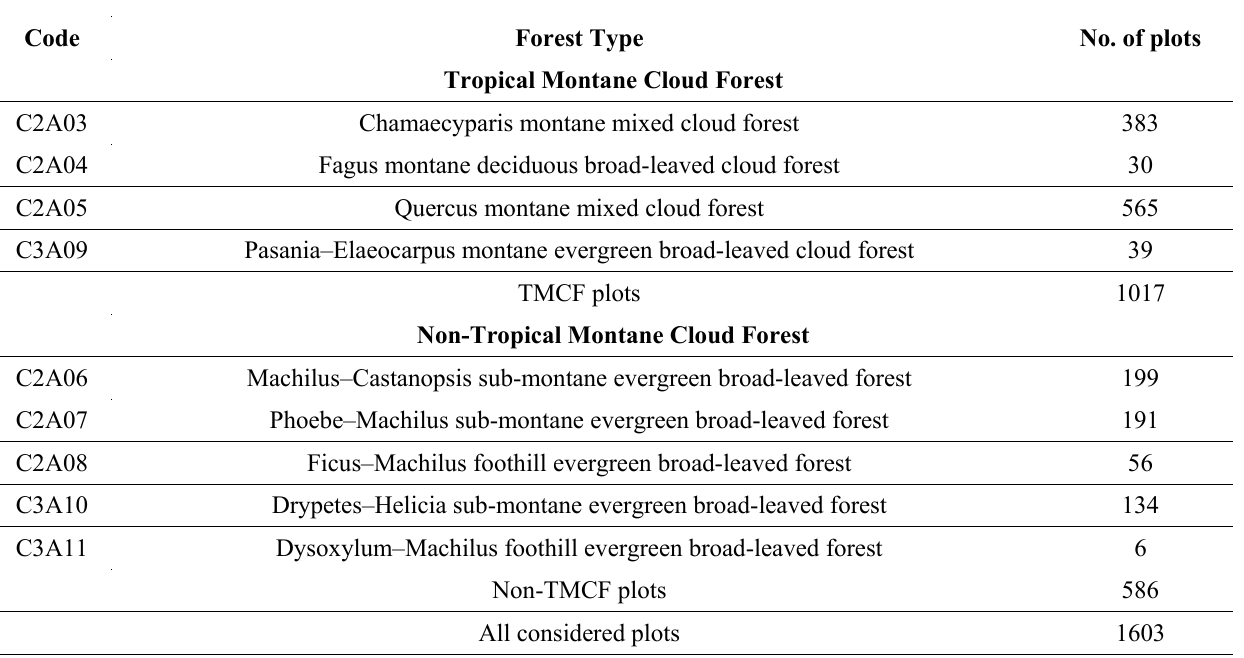
Table 1. Number of considered plots for 19 forest types (4 TMCF and 15 non-TMCF) in Taiwan coded and classified by Li et al.